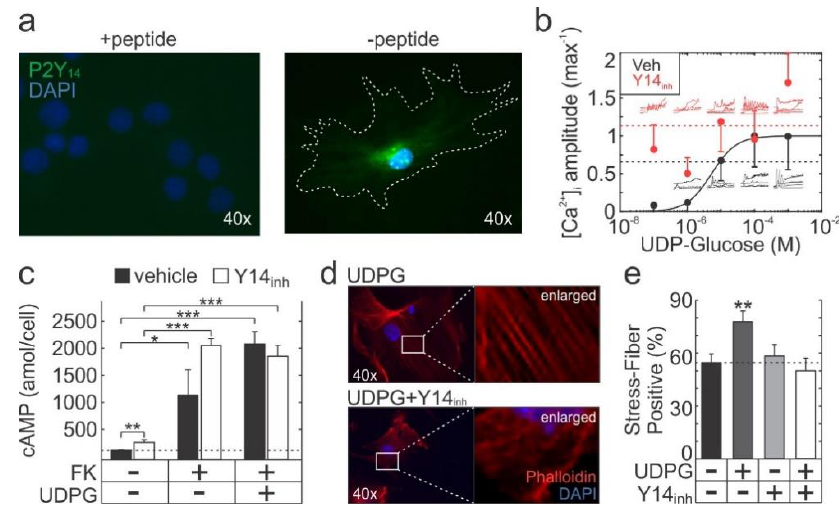
Figure 1. P2Y 14 expression and signalling in primary osteoblasts. ( a ) Representative image of P2Y 14 immunofluorescence in CB-Ob cells. Formalin-fixed cells were incubated with P2Y 14 antibody (with or without blocking peptide) followed by secondary FITC-conjugated antibody and nuclei were counter-stained with DAPI. ( b ) Fura2-loaded CB-Ob cells pretreated 10 min with 0.1% DMSO (vehicle; veh) or 100 nM PPTN (Y14 inh ) were stimulated with UDP-glucose (UDPG) and [Ca 2 + ] i elevation amplitudes were estimated from live-cell recordings. Solid black line: Hill function, dashed lines: Global means (pooled across all concentrations). Data are means ± sem, n = 3 independent experiments with 5–12 cells imaged per experiment. ( c ) Intracellular cAMP concentrations in CB-Ob cultures pretreated with vehicle or Y14 inh (10 min) and stimulated with 10 µ M forskolin (FK) and / or 10 µ M UDPG (30 min) before collecting samples for measurement. Data are means ± sem, n = 3 independent cell cultures. ( d , e ) Actin cytoskeleton in phalloidin-stained CB-Ob cultures pretreated with vehicle or Y14 inh (10 min) and stimulated with UDPG (10 min). Stress fibre prevalence was determined as the percentage of cells that exhibited stress-fibres. Representative images for UDPG and UDPG + Y14 conditions, along with contrast-enhanced enlargements are shown ( d ). Data are means ± sem, n = 2 independent cultures, 13–18 cells assessed per culture per condition ( e ). Significance assessed by t-test with Bonferroni correction; p < 0.05 *, p < 0.01 ** and p < 0.001